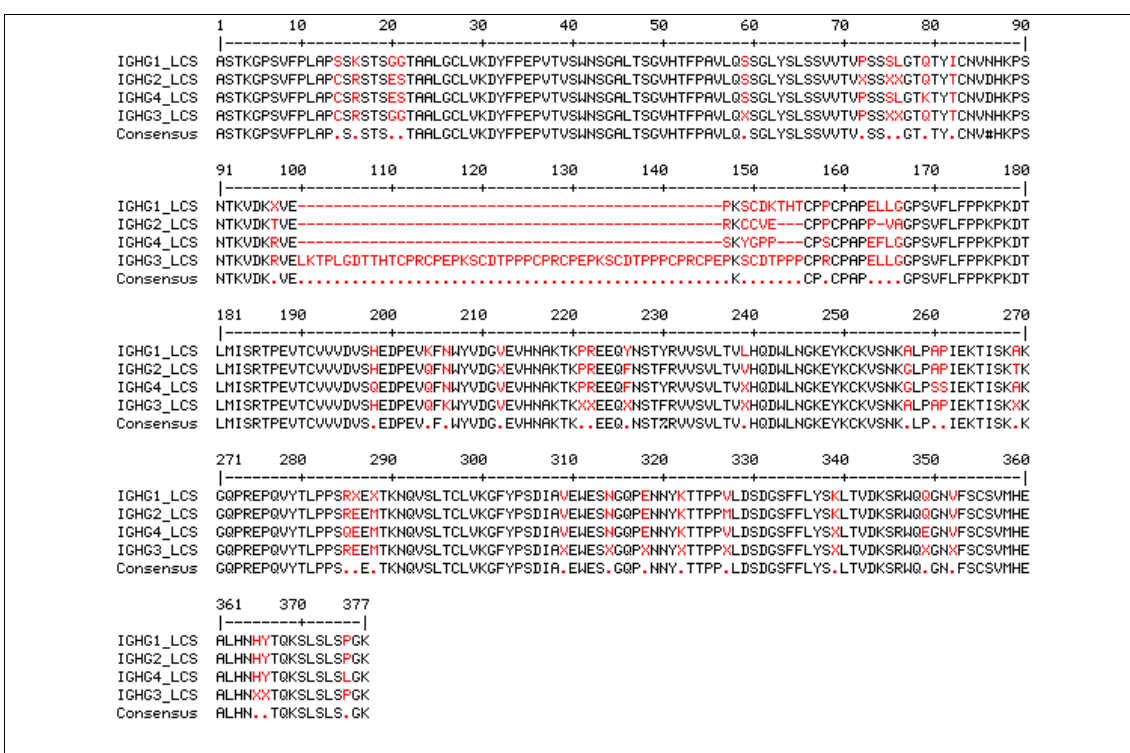
Figure 2. Amino-acid sequence alignment of the “least common” CH domains of IgG1, IgG2, IgG3 and IgG4. The reference amino-acid sequences for the individual IgG subclasses and their respective allelic variants were obtained from the IMGT-database (imgt.cines.fr). [Stadlmann J, Pabst M, Weber A, Anderle H, Schwarz